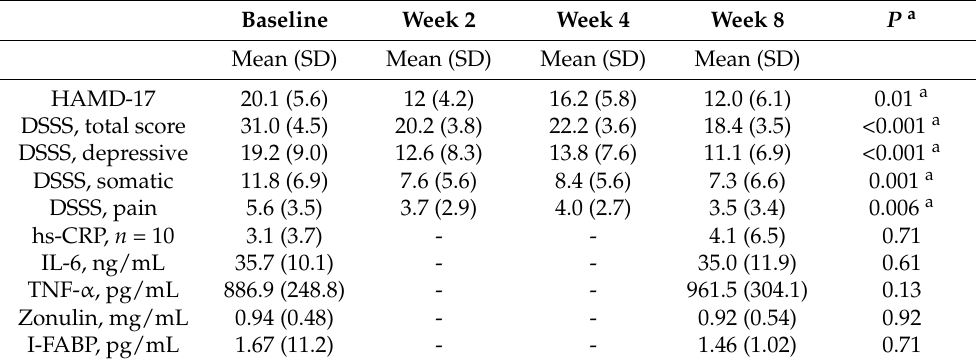
Table 1. Changes of depression and markers of inflammation and gut permeability during 8-week PS-128 intervention ( n = 11).